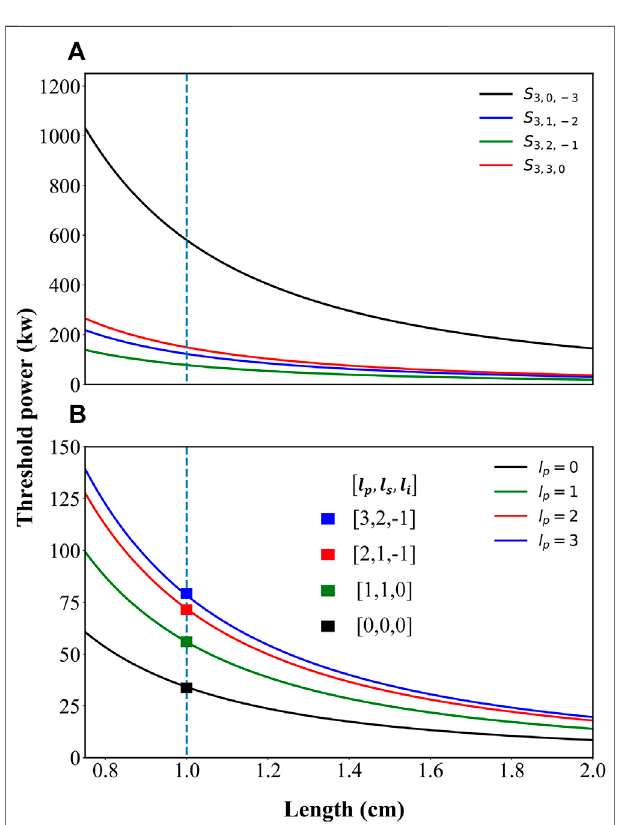
FIGURE 3 | Relationship between the OPO threshold and the sample length. (A) Situationsforall[l s , l i ]combinationswhenthetopologicalchargeof the pump wave is set to be l p (cid:2) 3. (B) Situations in which the [l s , l i ] combination takes the largest overlap integral with different topological charge of the pump wave.